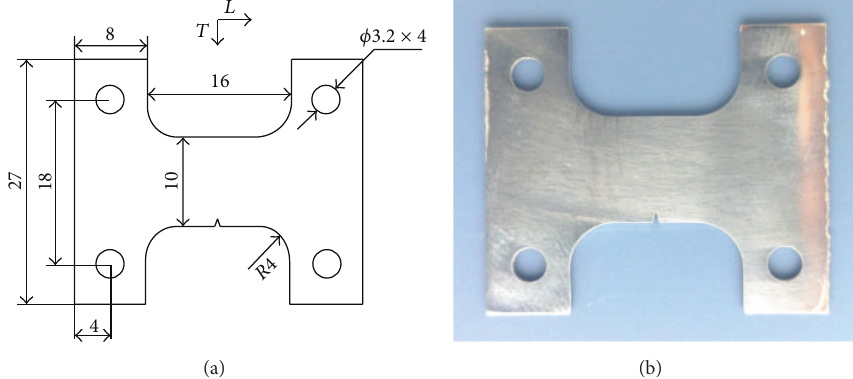
Figure 1: Geometry of the sample: (a) the sample design. (b) Manufactured sample (unit: mm).